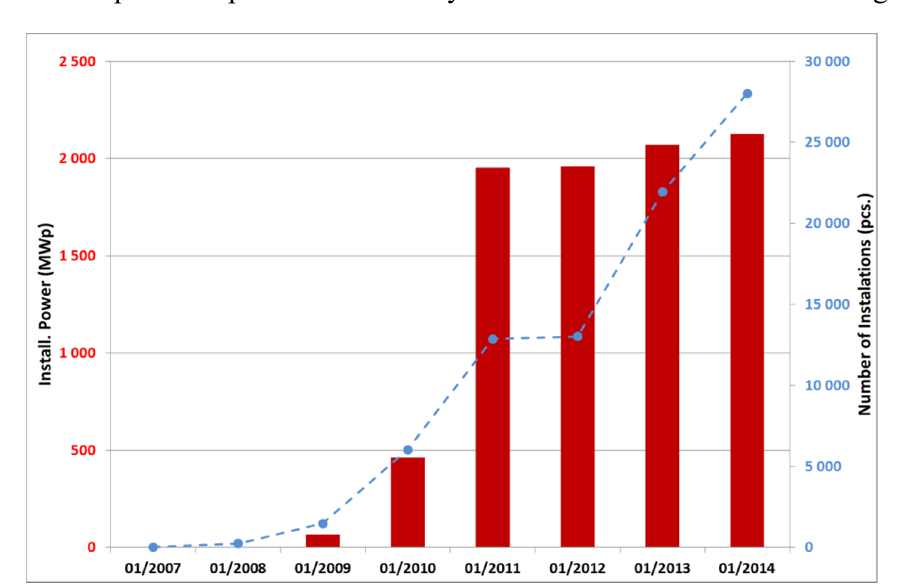
Figure 1. Development of photovoltaic (PV) installations in the Czech Republic (CR) (2007–2014)